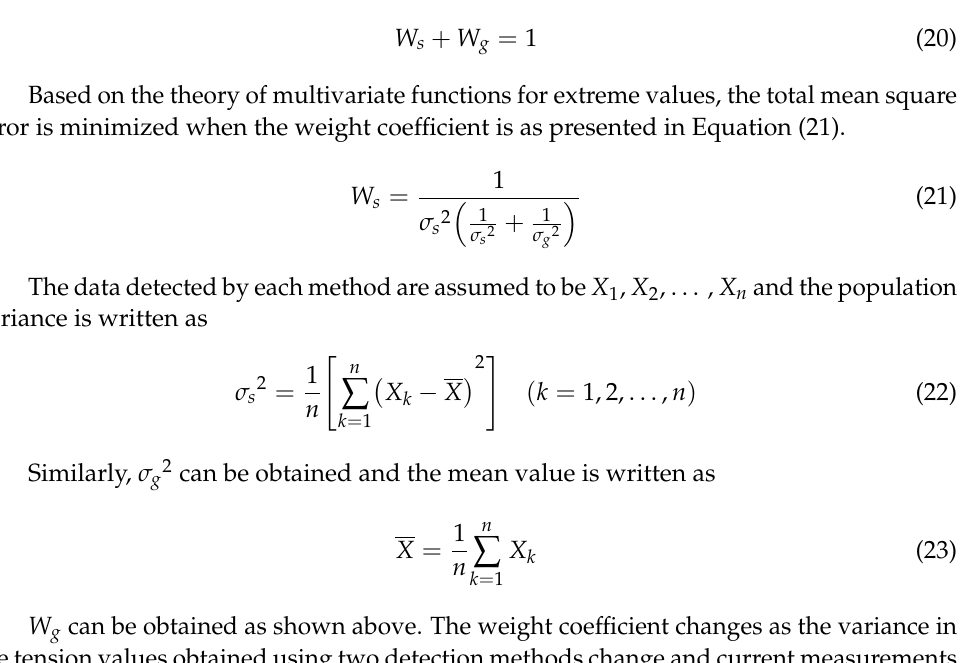
Figure 4. Adaptive weighted fusion algorithm structure.